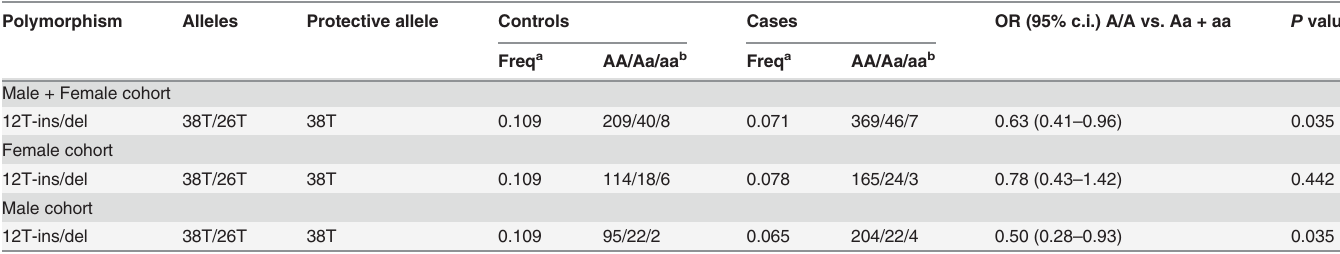
Table 2. ATP1A1 single variant association